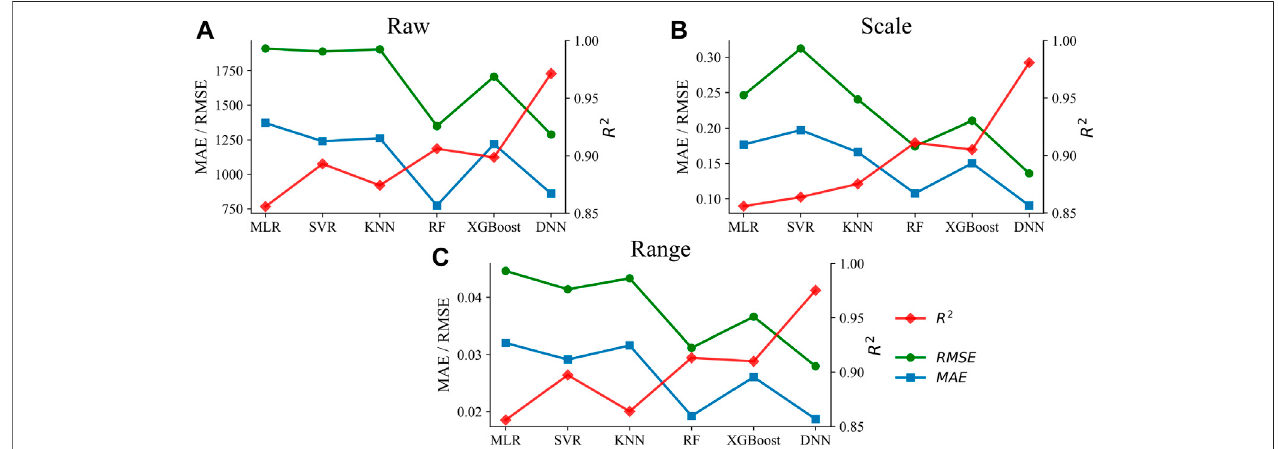
FIGURE 7 | Comparisons of algorithms predicts performance under different preprocess methods. (A) is Raw , (B) is Scale , (C) is Range .